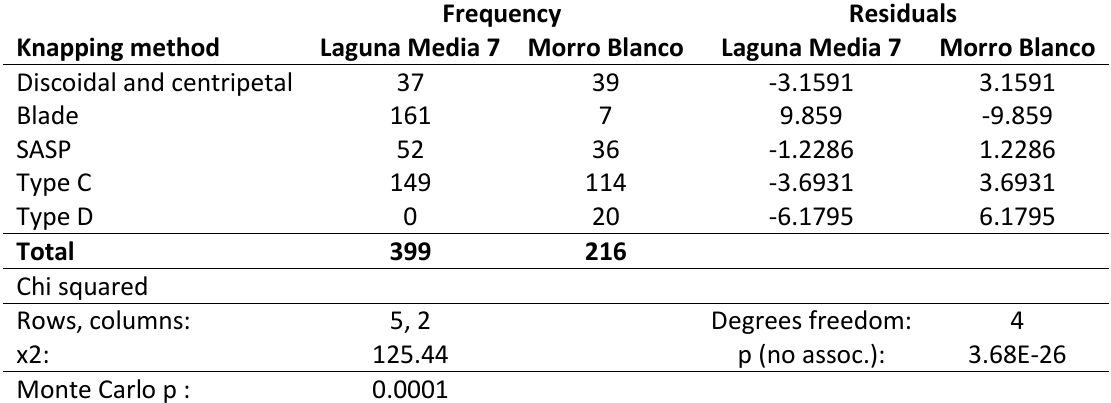
Table 8. Frequencies and normalized residuals for the knapping methods from Laguna Media 7 and Morro Blanco - x 2 and Monte Carlo